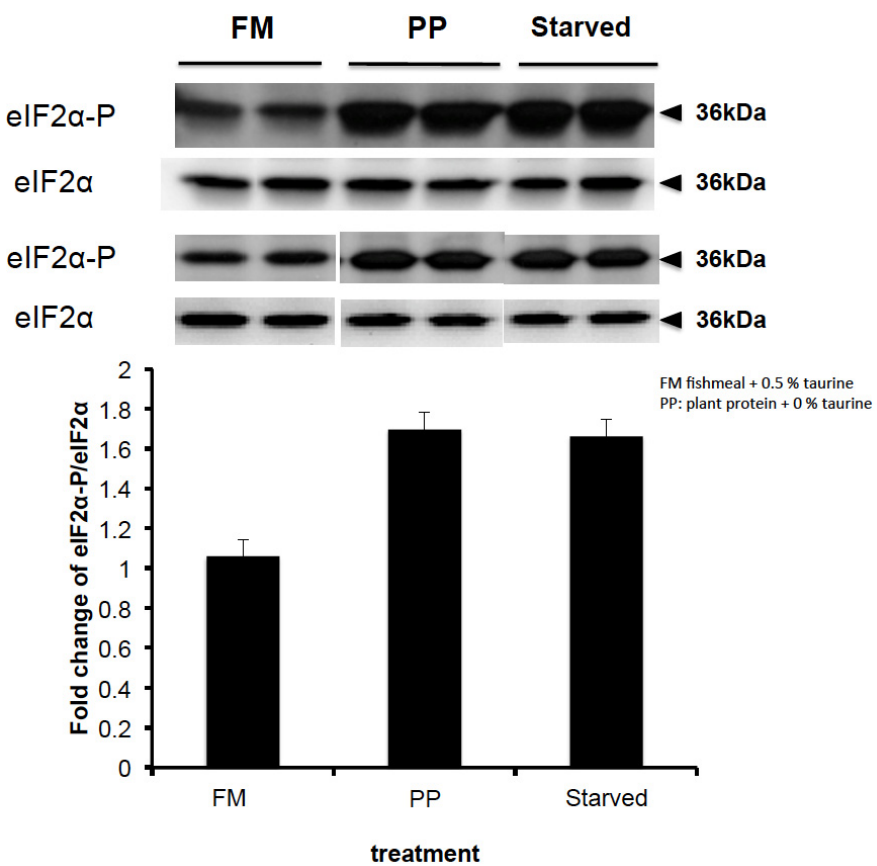
Figure 6. Comparison of eIF2 α phosphorylation in livers of cobia fed a fish meal versus a plant protein diet. Cobia juveniles maintained for 12 weeks on an all plant protein diet, PP, were compared with animals fed a mixed fish meal/plant protein diet, FM [6] and unfed fish. The complete formulations are given in Supplemental Table S2. Proteins in liver extracts were fractionated by SDS-PAGE and transferred to PVDF. Phosphorylated and total eIF2 α were visualized by enhanced chemiluminescence, using an antibody to phosphorylated eIF2 α and (after stripping) antibodies to total eIF2 α , as described in the legend in Figure 4. Values obtained for the level of phosphorylated eIF2 α were normalized for the total level of eIF2 α present in the sample and expressed as the relative density of phosphorylated to total eIF2 α with the bar diagrams in lower panels corresponding to the respective lanes in the upper panel. 3.8.2. Comparison of eIF2 α Phosphorylation in Livers of Fish Fed a Reference Diet Ver- sus a Diet with Soy Protein Using the Non-GMO Soybean Cultivar 3010 Although fish meal can be replaced at least in part by soybean concentrate, most commercially available soybean products are from genetically modified organisms (GMOs), the use of which is not universally accepted. Schillinger Genetics, Inc. has devel- oped multiple soybean cultivars with potential as fishmeal replacements in diets for aq- uaculture. Cultivars have been developed with reduced levels of the anti-nutritional fac- tors raffinose, stachyose, and trypsin inhibitors. A diet was formulated, 3010-50, to replace 50% of protein supplied by fishmeal with a cooked, solvent-extracted soybean meal for- mulation 3010 from Schillinger Genetics Inc. Poultry meal, wheat flour, soy protein con- centrate, corn, and fish oil were all varied to maintain the 3010-50 diet isonitrogenous, isolipidic, and isocaloric qualities compared with the reference diet, FM, and to contain similar amino acid profiles. The diets differ significantly in menhaden and poultry meal, soy protein concentrate, NPF1-3010, and menhaden oil. The 3010-50 diet is also supple- mented with 0.15% taurine. The performance characteristics of 3010-50 in a 12-week trial